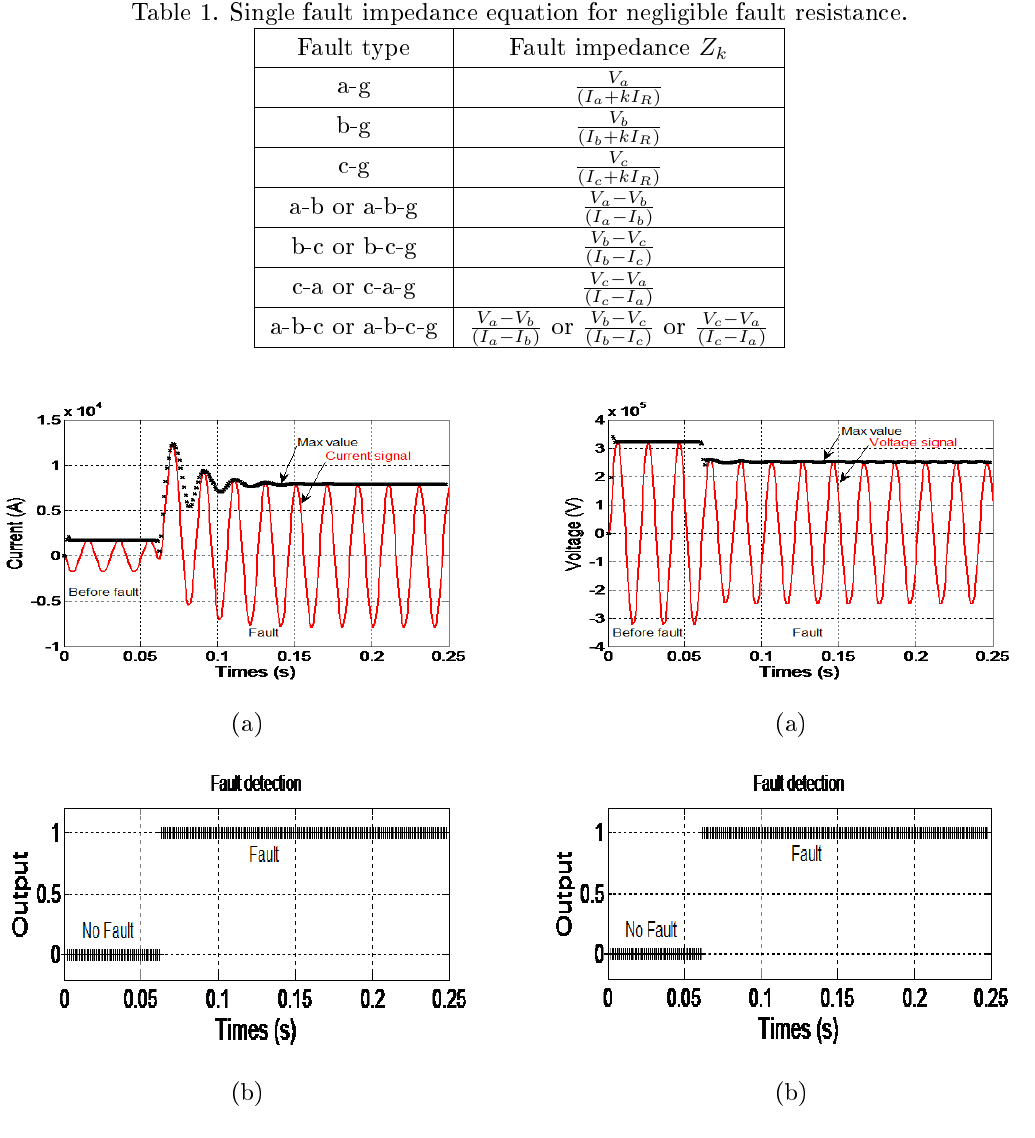
Fig. 4: Fault detector output using the maximum cur- rent value.